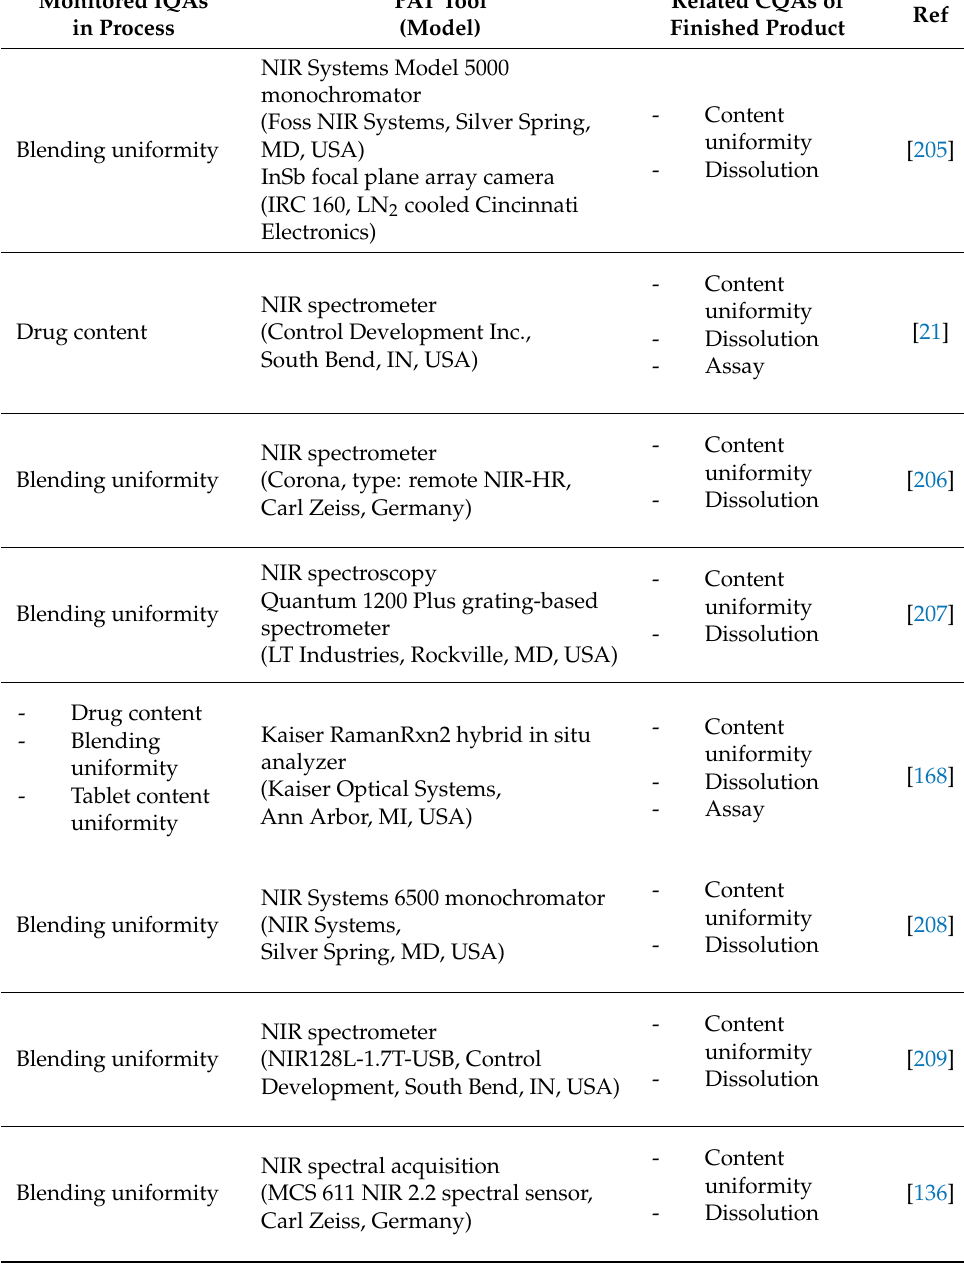
Table 2. Summary of PAT-based modeling method applied in blending